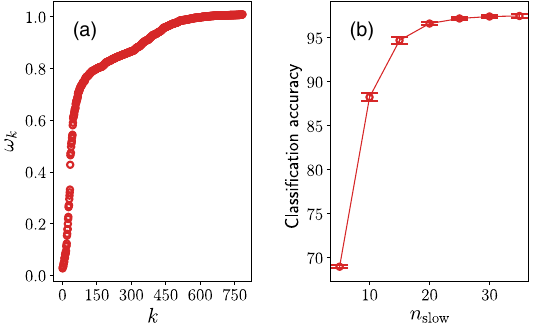
FIG. 7. (a) The learned frequencies of the MNIST dataset. (b) Classification accuracy on the test dataset based on n slowest